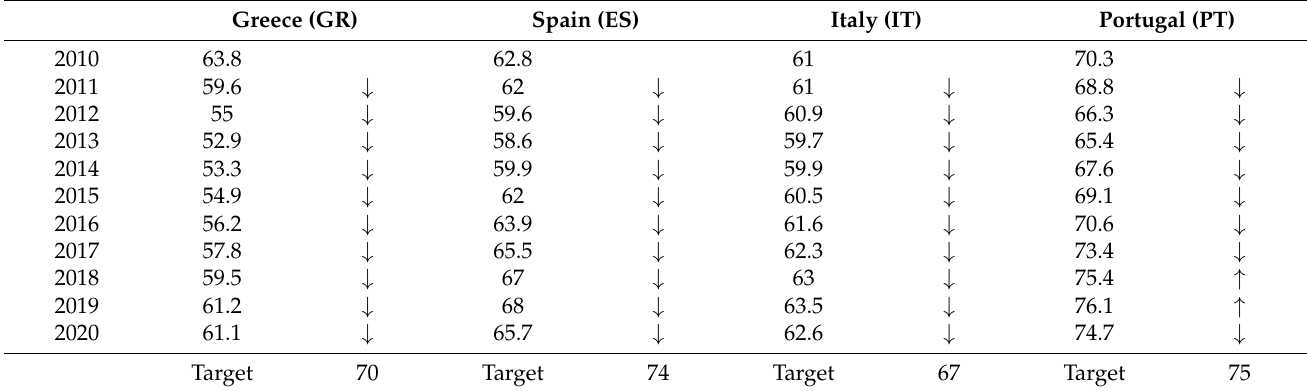
Table 1. Employment rate, age group 20–64, 2010–2020